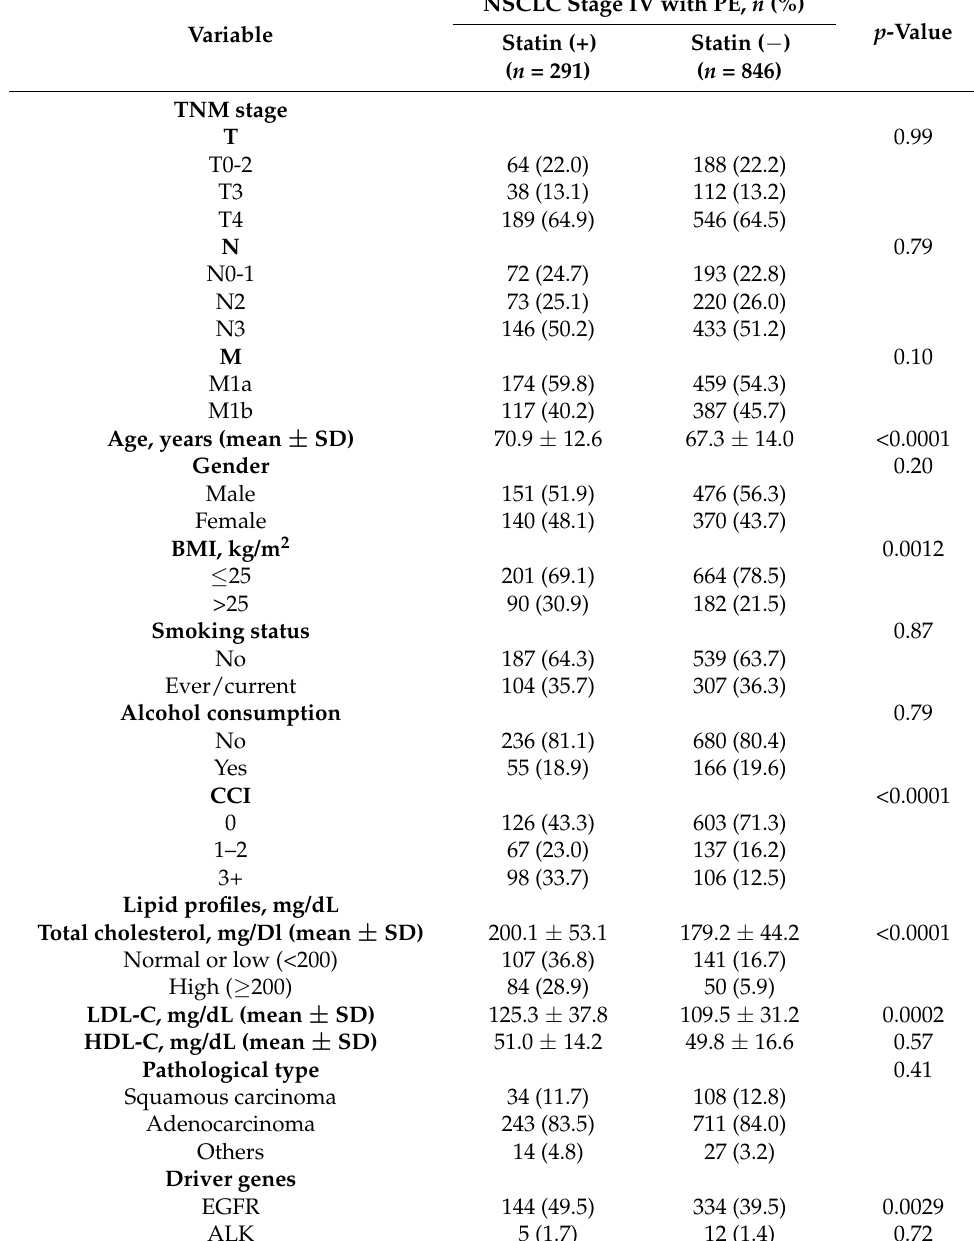
Table 1. Characteristic of NSCLC stage IV patients with PE ( n = 1137).